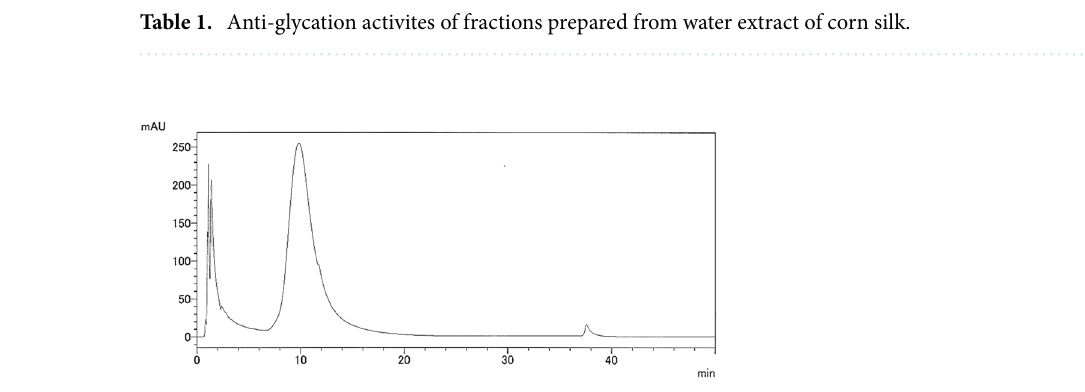
Figure 2. HPLC chromatogram of the > 3 kDa fraction of the corn silk water extract.